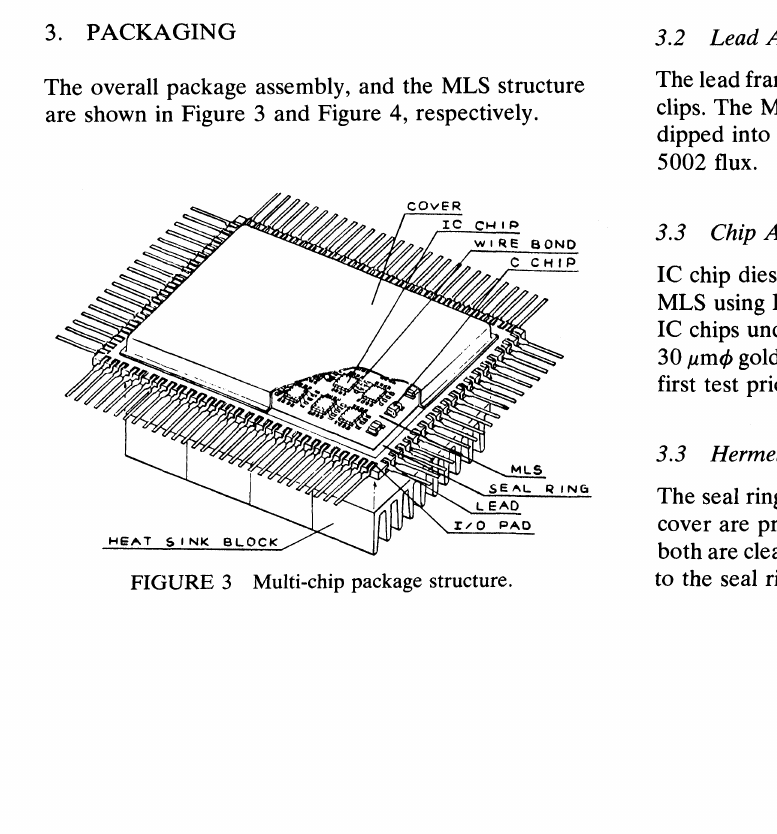
FIGURE 2 Multi-chip package.